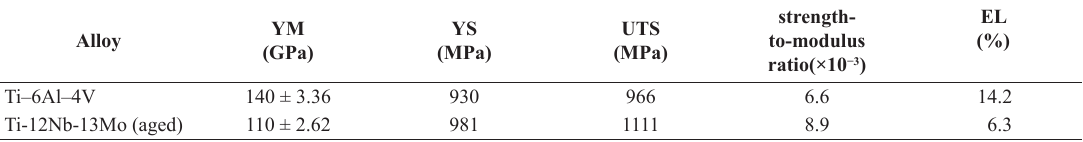
Table 2. Mechanical properties of Ti-6Al-4V and aged Ti-12Nb-13Mo alloys. Alloy